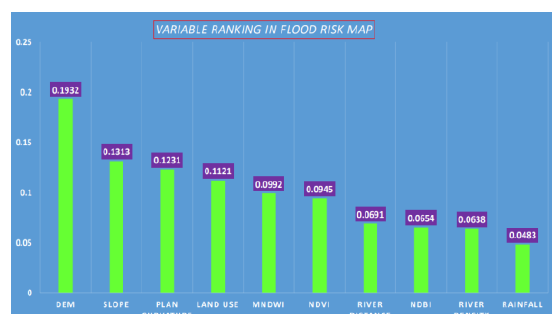
Figure 10 . Bar chart for Relative importance of the